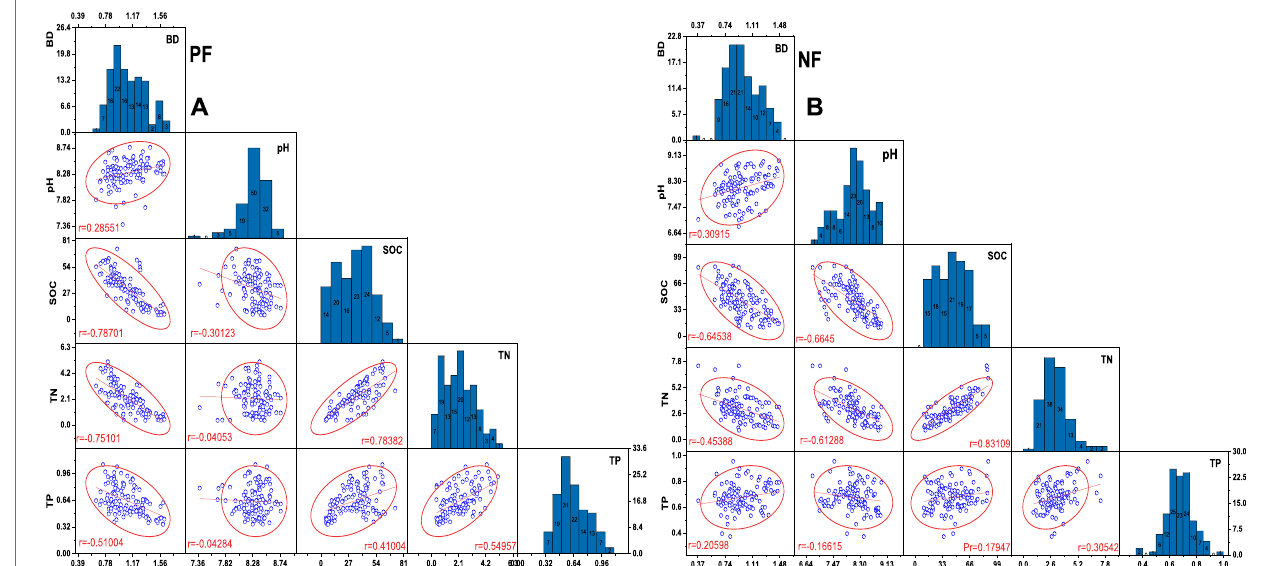
FIGURE6| Pearson ’ scorrelationscattermatrixforthephysiochemicalsoilpropertiesunderPFandNFat0 – 100 cmsoildepth.TheBD,SOC,TN,andTPindicate the soil bulk density, the contents of soil organic carbon, total nitrogen, and total phosphorus, respectively.